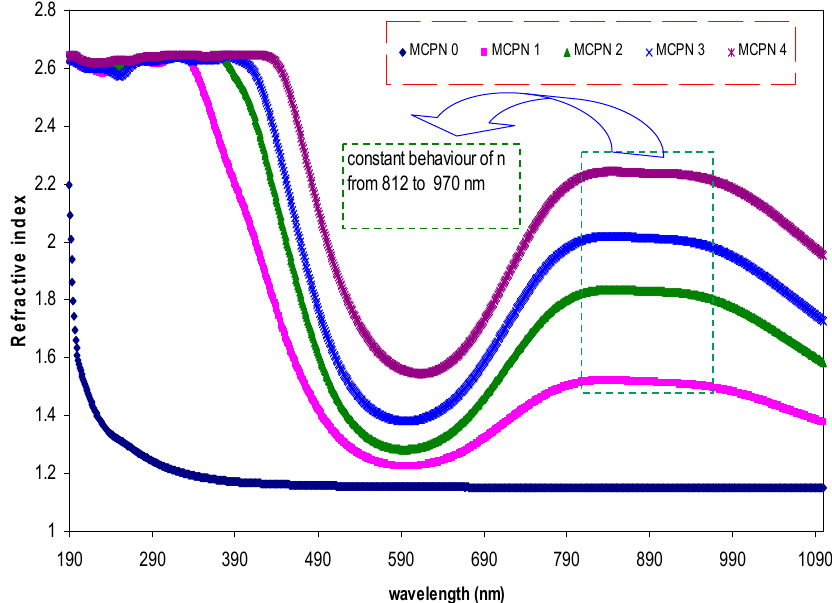
Figure 4. Index of refraction (n) versus wavelength for pure MC and doped MC samples.